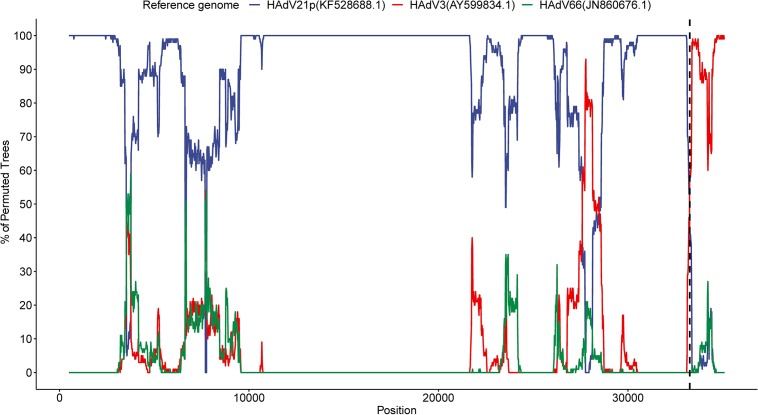
Bootscan analysis based on multiple alignment of the current isolate, HAdV3, HAdV21p, and HAdV66 genomes. The current genome was selected as the query sequence, whereas the rest were references. The dashed line represents the approximate position 33,260 in the present genome.